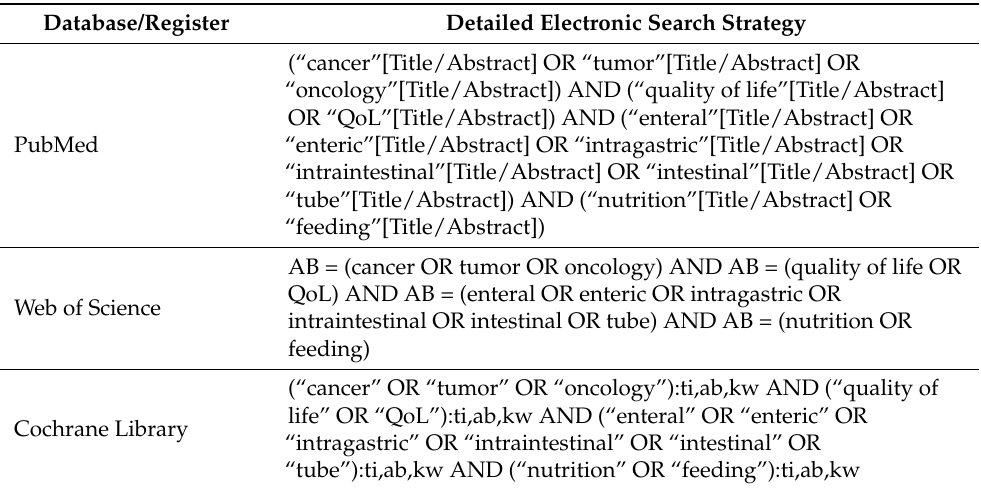
Table 2. The detailed electronic search strategy applied within the systematic review for the PubMed and Web of Science databases, as well as Cochrane Central Register of Controlled